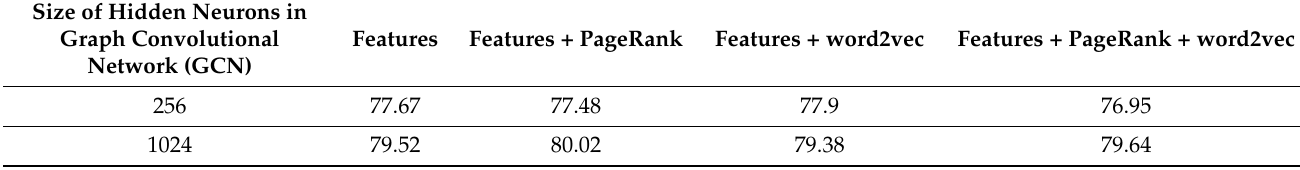
Table 9. Model accuracy by graph convolutional